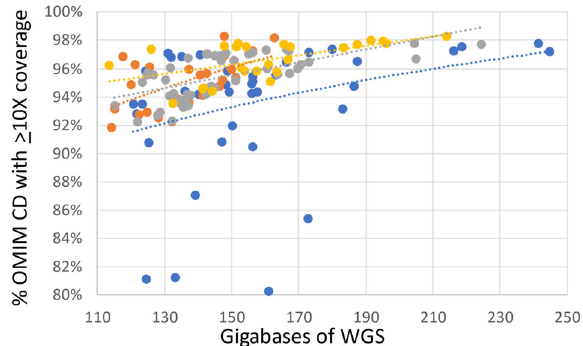
Fig. 3 Relationship between sequence depth and proportion of genes with complete coverage. Relationship between percentage of Mendelian Inheritance in Man (MIM) genes with at least 10-fold coverage of all coding domain nucleotides and amount of WGS. Shown are WGS from DBS prepared with the Illumina method (orange) or KAPA method (sky blue) and matched blood samples prepared with the Illumina method (gray) or KAPA method (yellow). Dotted trend lines are